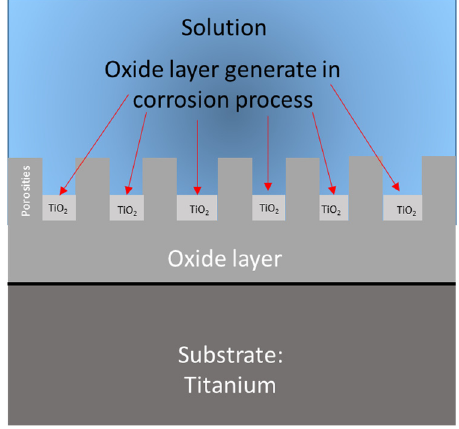
Figure 10. Schematization of oxide growth calculated by capacitance.